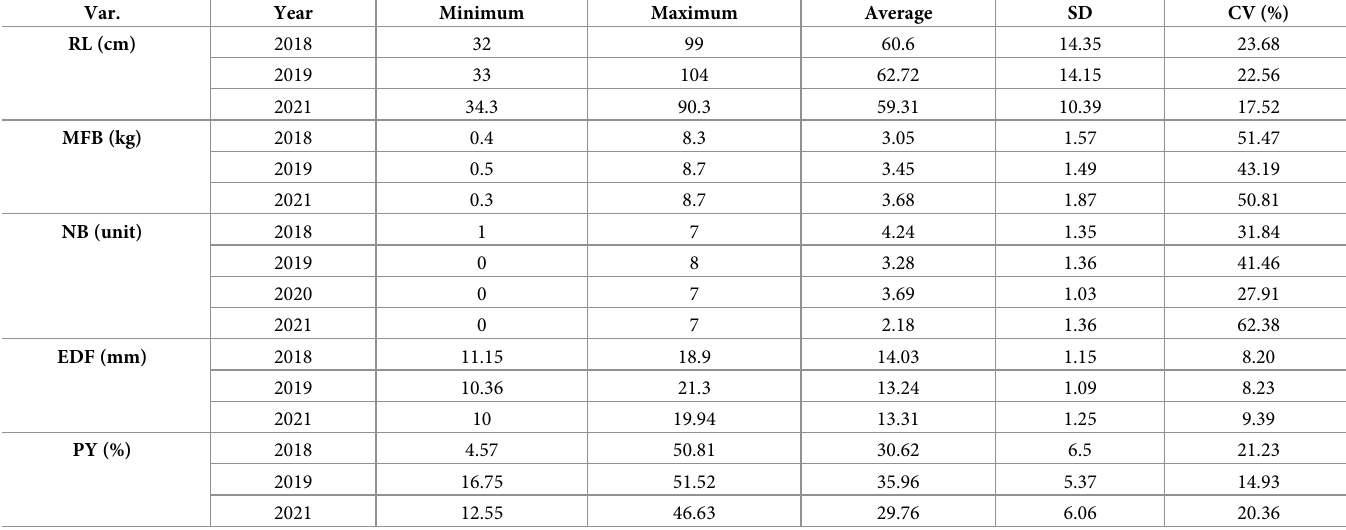
Table 1. Summary of the descriptive statistics. Amplitudes, mean, standard deviation (SD) and coefficient of variation (CV) for rachis length (RL), fruit mass per bunch (MFB), number of bunches (NB), equatorial fruit diameter (EDF) and pulp yield (PY) for the years 2018, 2019, 2020 and 2021.